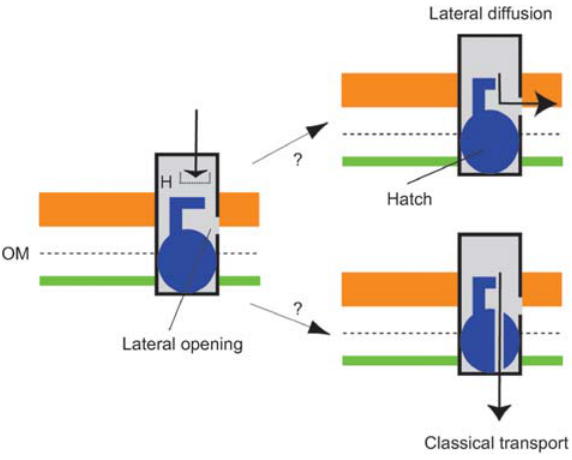
Figure 4 Two possible transport mechanisms for FadL channels. After initial substrate recognition by the low-affinity binding groove and substrate diffusion into the adjacent high-affinity binding site (H), substrate transport can occur either via lateral diffusion or via a classical mechanism. The polar layer of the LPS, representing the principal barrier for transport, is shown in orange. See text for